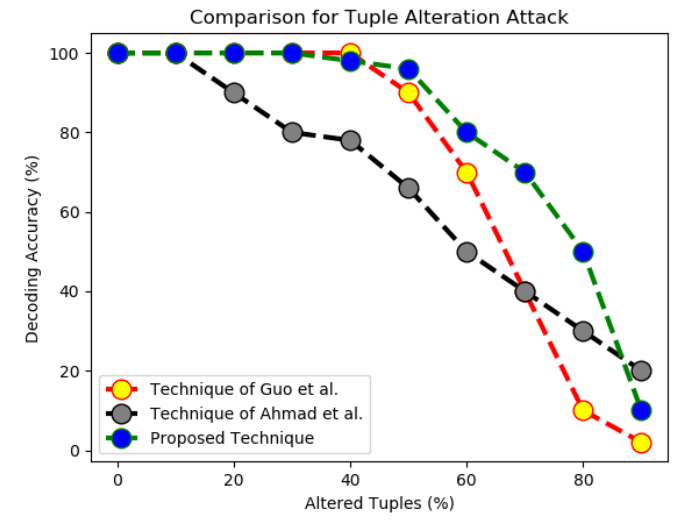
Figure 7. Comparison of techniques for tuple alteration attacks.